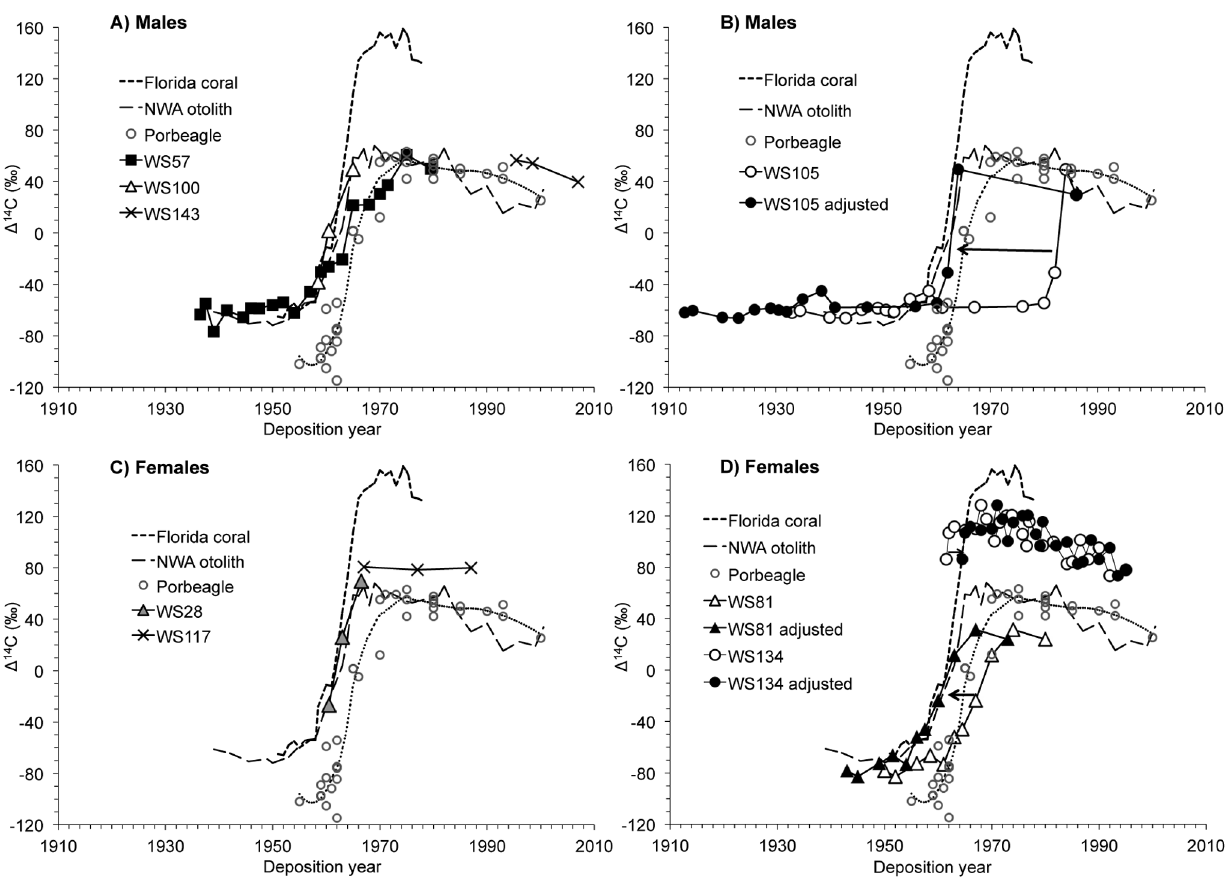
Figure 2. White shark D 14 C results compared to three D 14 C reference chronologies [ 11,31,32 ] . Results from male (A, B) and female (C, D) white shark vertebrae. Dotted line is porbeagle data smoothed with a Loess curve. For panels B and D, the arrows indicates the vertebral D 14 C curves that had to be shifted to line up with the reference chronologies (white open symbols are initial data, black symbols are data shifted to align with the references).